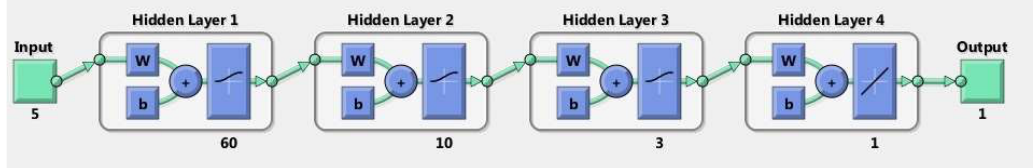
11 of 25 Figure 9. Torque neural network regression. analysis (outputs vs targets). 2.2.3. Thrust ANN A feed-forward artificial neural network was developed where the experimental data from the surface-piercing propeller are reproduced by the trained network. The internal structure of the thrust newral network is shown in Figure 10. The characteristics of the thrust neural network are the following:  Four layers; 